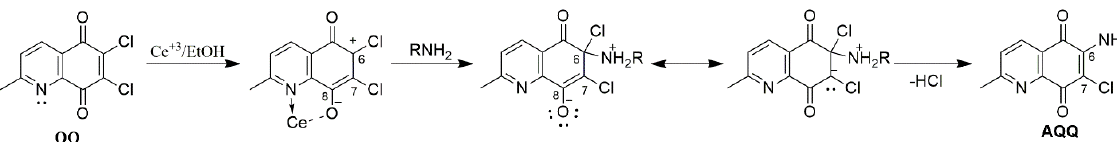
Figure 3. Preferential nucleophilic substitution with the addition of CeCl 3 7H 2 O at C-6.